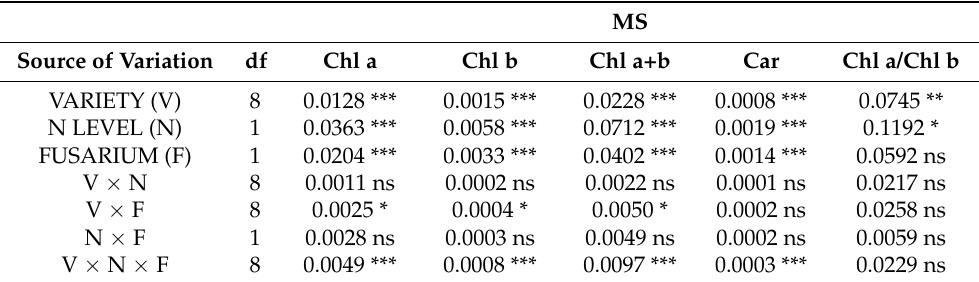
Table 3. Three-way ANOVA for different chloroplast pigments under different nitrogen and Fusarium treatment in spikes of nine winter wheat